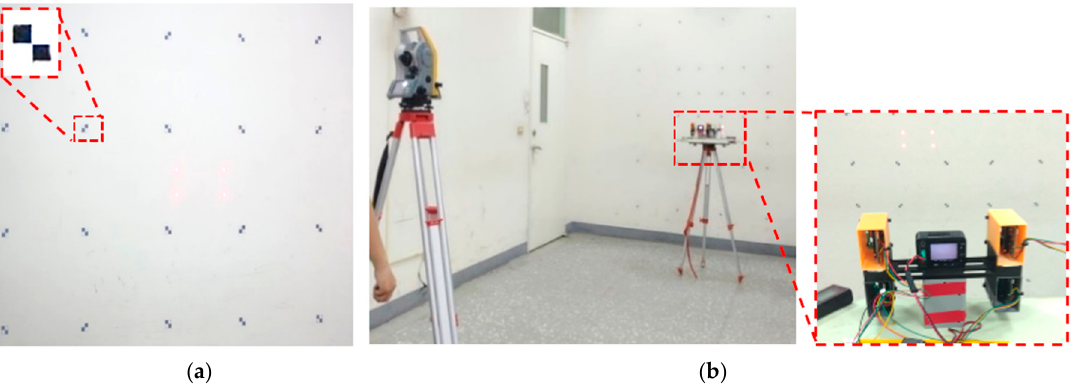
( d ) Figure 7. Structural dimensions of the camera and laser ranging modules: ( a ) three-dimensional image; ( b ) top view; ( c ) front view; ( d ) left view. The spatial relationships between the laser beam vectors of the ranging modules and the camera focus have crucial effects on the measurement methods for the developed sys- tem. Therefore, a calibration procedure was designed to investigate the aforementioned spatial relationships. The steps in this procedure were as follows: (1) The positions of the ranging modules were adjusted so that the four laser beams were nearly parallel to each other. Subsequently, the measurement accuracy was increased by measuring the laser beam vectors after calibration. (2) As the spatial relationships between the laser beam vectors and the camera focus could not be directly measured, control points were marked on the wall of a research room, and relative spatial coordinates were measured using a total station. The room served as the system calibration site. Photos containing laser light spots and control points were captured from different distances (Figure 8a), and photogrammetry was used to calculate the spatial relationships between the laser beam vectors and the laser light spots, as well as those between the laser beam vectors and the control points. The experimental distance was increased from 1 to 3 m in 0.5-m increments.